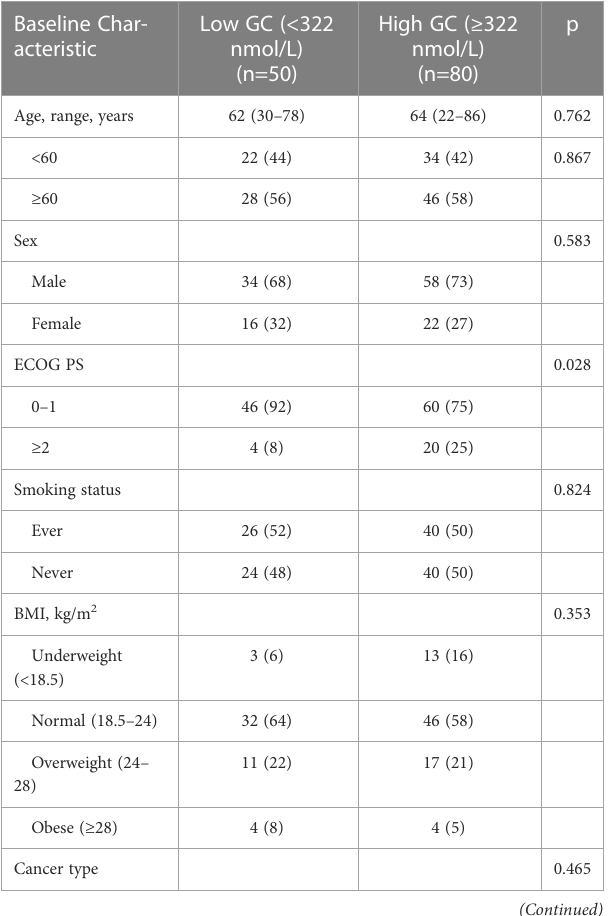
TABLE 1 Baseline characteristics of included patients with advanced or metastatic cancer.